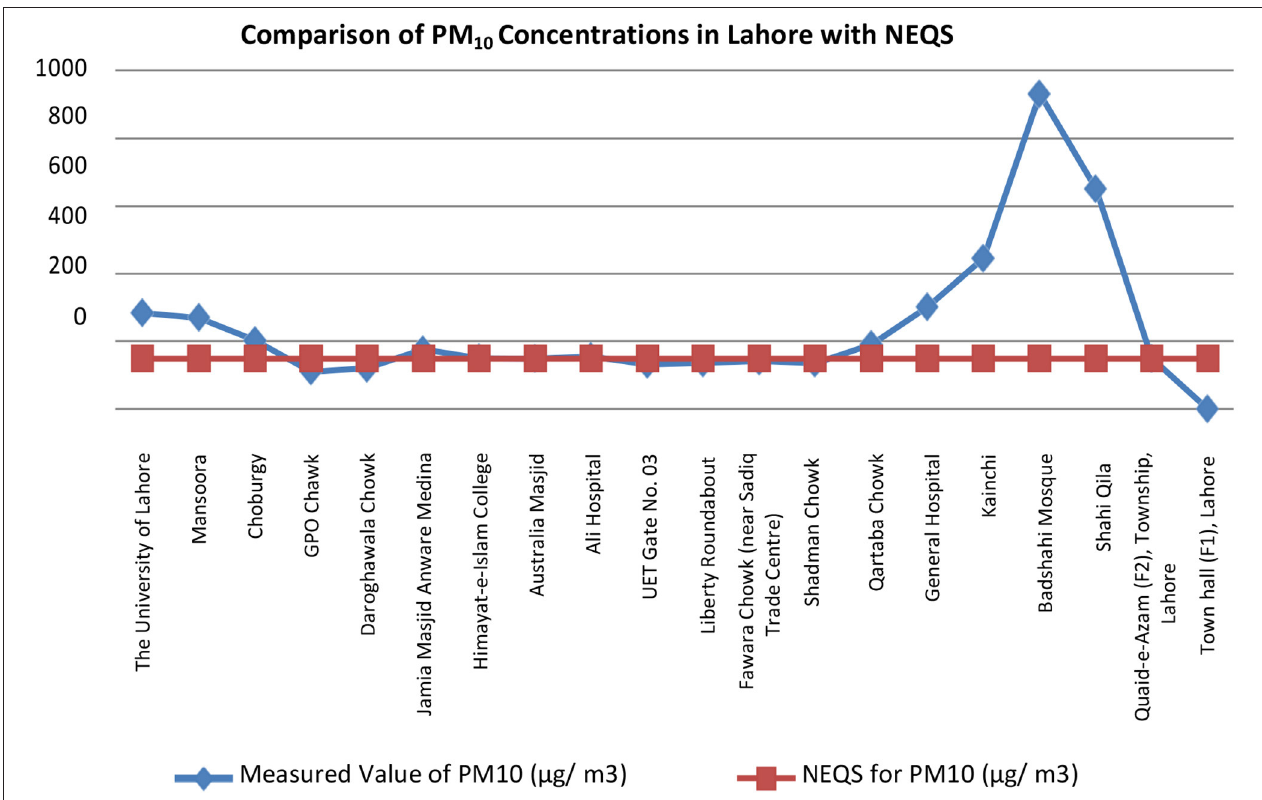
FIGURE 6 | Comparison of PM 10 concentrations in Lahore with